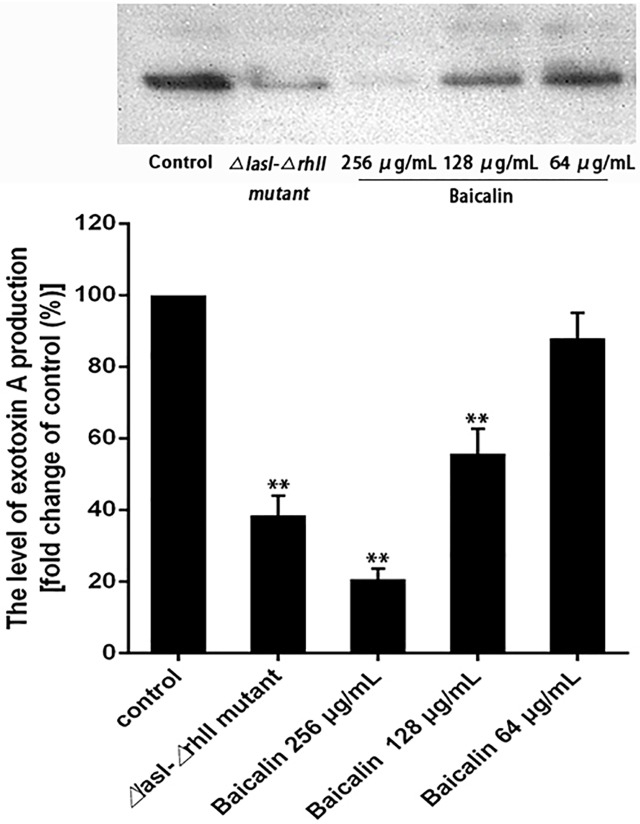
Effects of baicalin on PEA production detected by western blotting.Top image: Western blot analysis of PEA in the control group and in groups treated with sub-MICs of baicalin (64, 128, and 256 μg/mL) for 24 h. Bottom image: band intensity quantitation based on densitometry. **P<0.01 versus the control group. Data are shown as the average of three experiments.